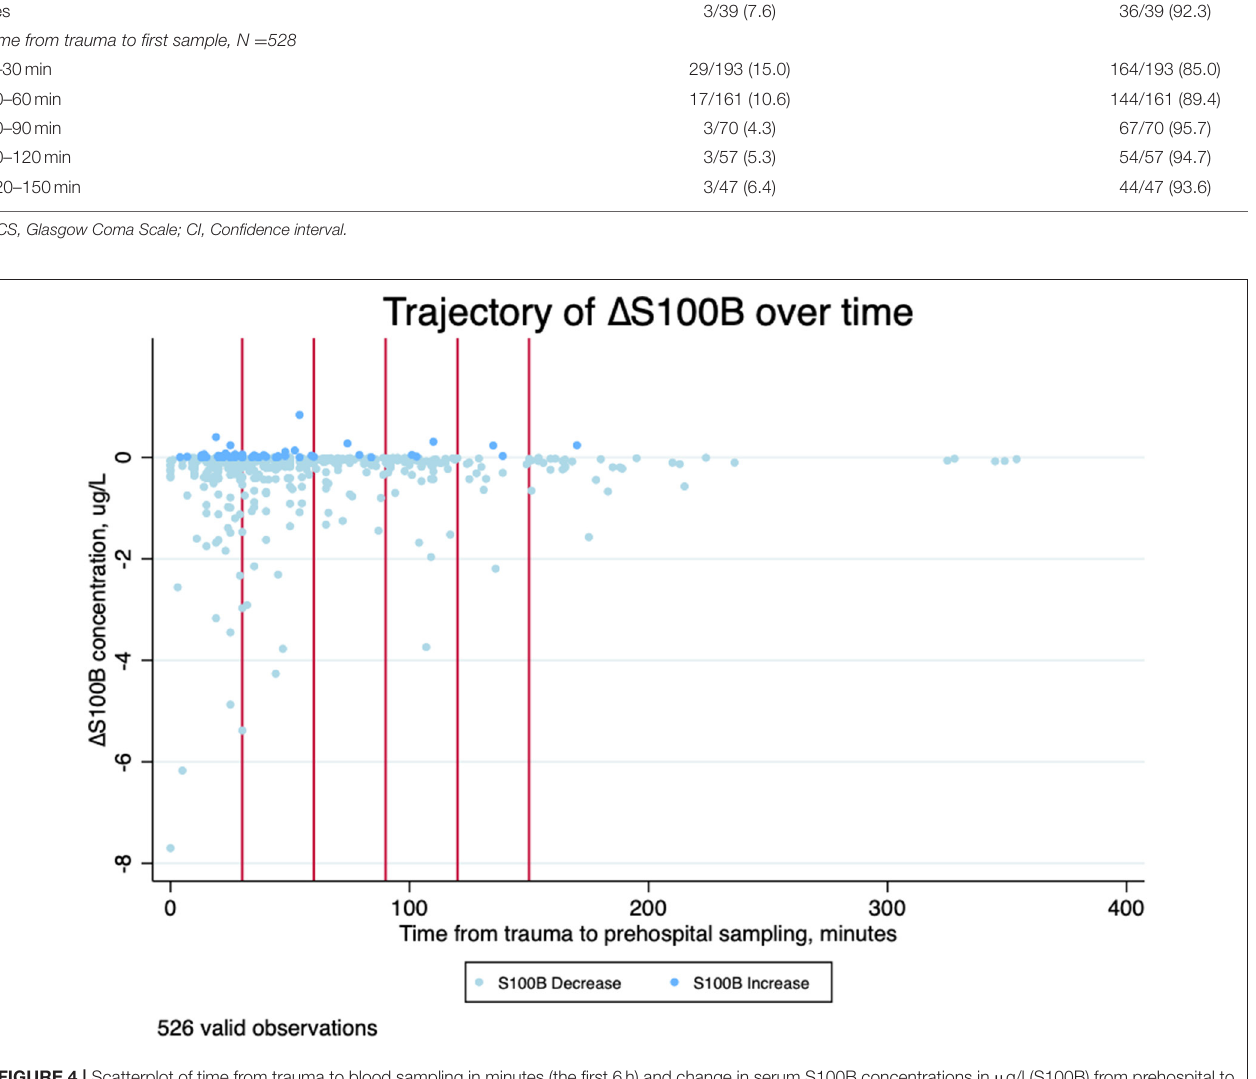
FIGURE 4 | Scatterplot of time from trauma to blood sampling in minutes (the first 6h) and change in serum S100B concentrations in µ g/l (S100B) from prehospital to in-hospital sampling stratified by trajectory (decreasing or increasing value). The red lines indicate 30, 60, 90, 120, and 150min after trauma. N = 526. samples was all well above the maximum monthly coefficient of decreasing trajectories, and the variation between consecutive variance of the used analyzer at 7.1% for both increasing and samples cannot solely be ascribed uncertainty of